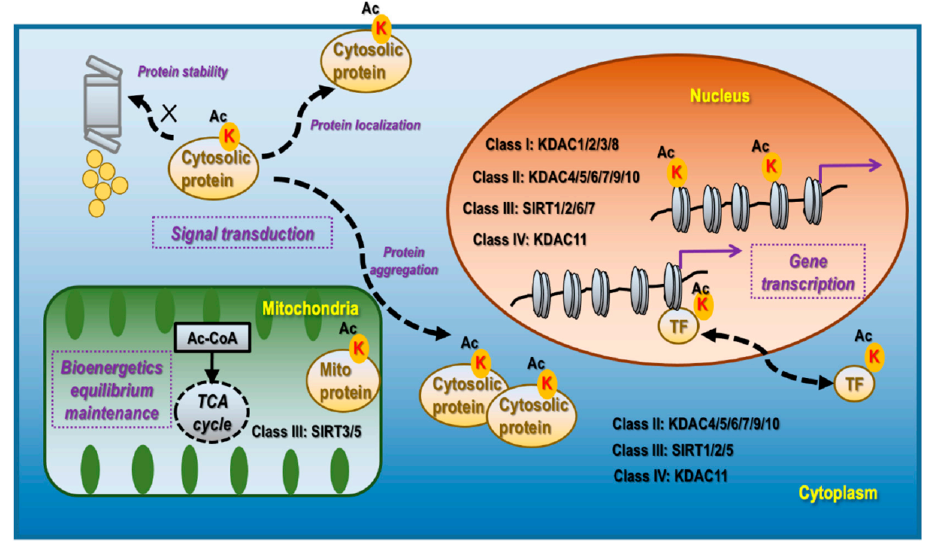
Figure 1. Cellular distribution, corresponding deacetylases, and primary functionalities of ly- sine acetylation. Lysine acetylation occurs in the nucleus, mitochondria, and cytoplasm. Nu- cleus lysine acetylation is deacetylated by class I deacetylases KDAC1/2/3/8, class II deacetylases KDAC4/5/6/7/9/10, class III deacetylases SIRT 1/2/6/7, Class IV deacetylase KDAC11; mitochon- dria lysine acetylation is deacetylated by class III deacetylases SIRT3/5; cytoplasm lysine acetylation is deacetylated by class II deacetylases KDAC4/5/6/7/9/10, class III deacetylase SIRT1/2/5, and class IV deacetylase KDAC11. Nucleus lysine acetylation can affect gene transcription via modulating chromatin structure if occurring on histones and regulate gene expression via controlling the localiza- tion, expression, and activity of TFs as well as the transcriptional machinery. Mitochondrial lysine acetylation can control the maintenance of bioenergetic equilibrium as acetyl-CoA is the substrate of acetylation and TCA cycle, and an important product of glycolysis. Cytoplasmic acetylation can affect signal transduction via modulating protein stability, localization, and aggregation, alone or together with other PTM